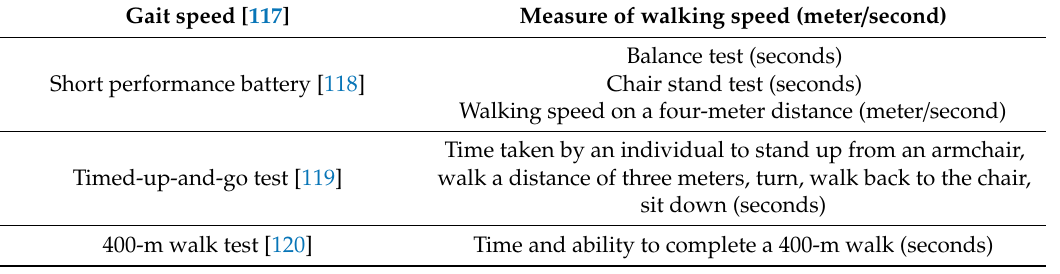
Table A3. Evaluation of physical performances.